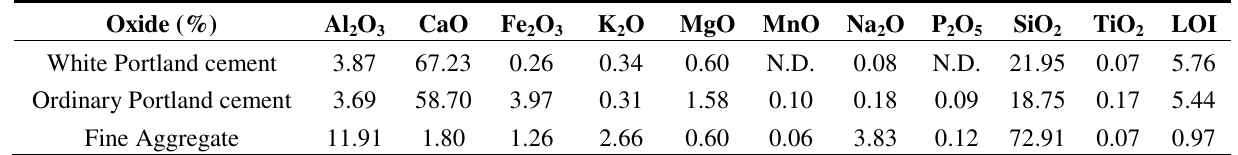
Table 3. Oxide composition of the cements and fine aggregate used to prepare the cement pastes and concrete mixtures. LOI means mass loss on ignition.